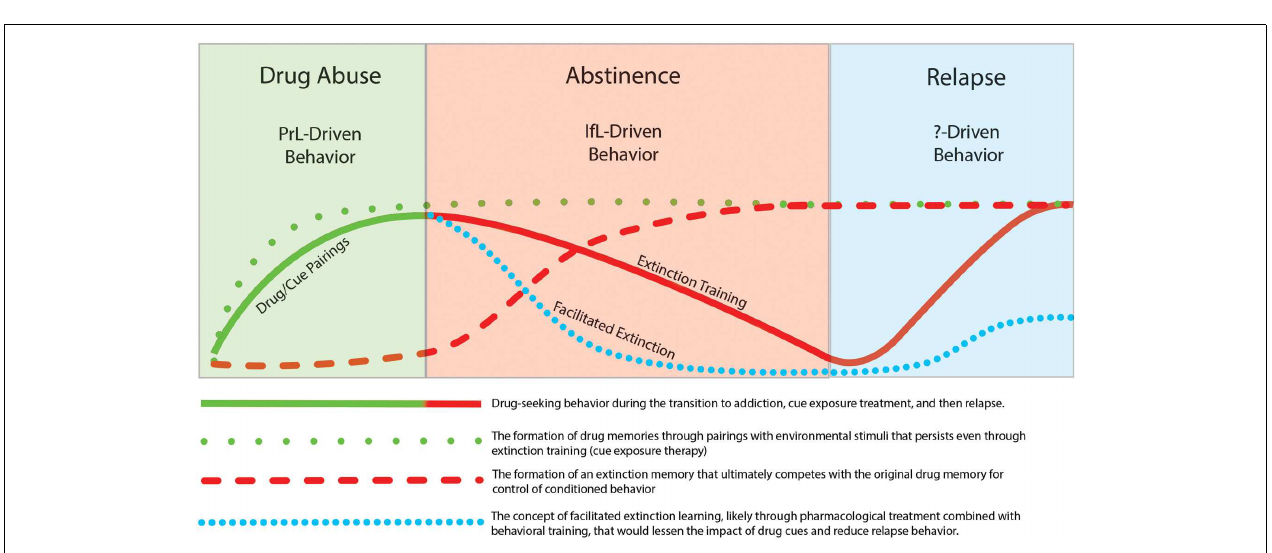
facilitation of the extinction process may promote a stronger and more persistent extinction memory that may lead to reductions in the rate of